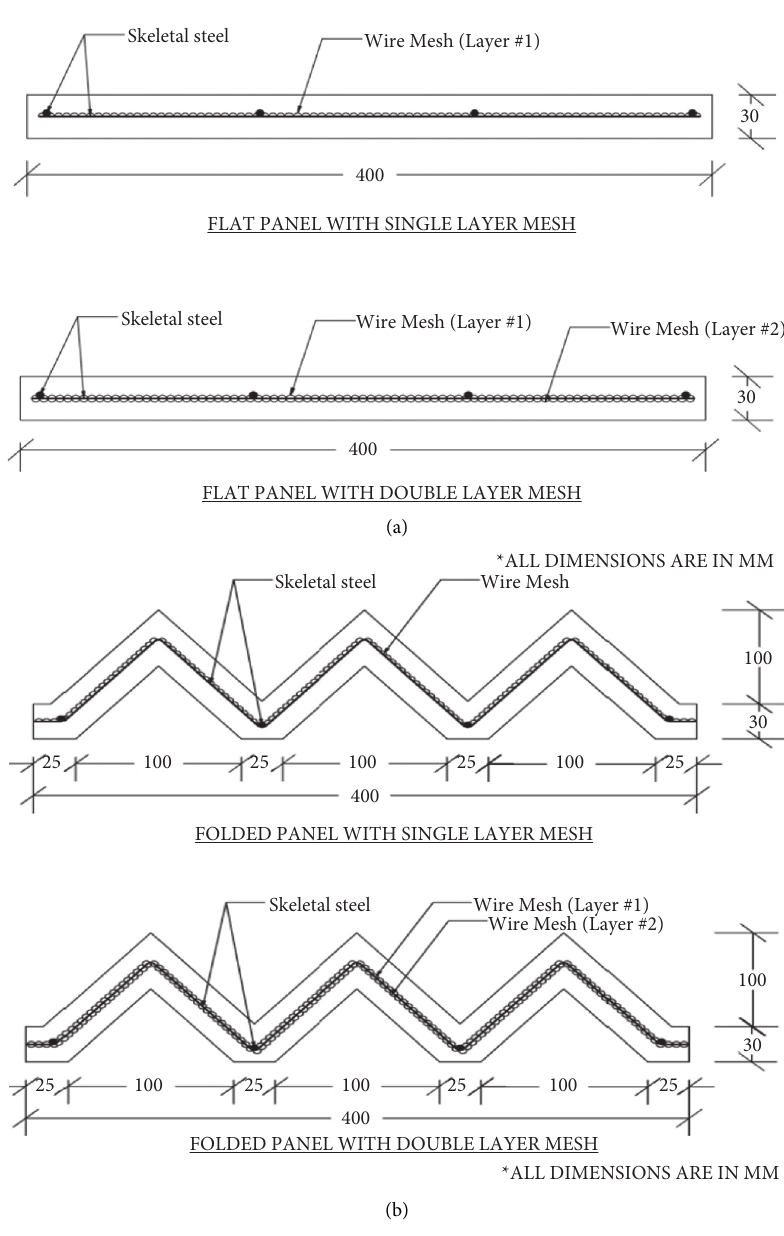
Figure 3: Geopolymer ferrocement panels with single and double layer wire mesh. (a) Flat panels. (b) Folded